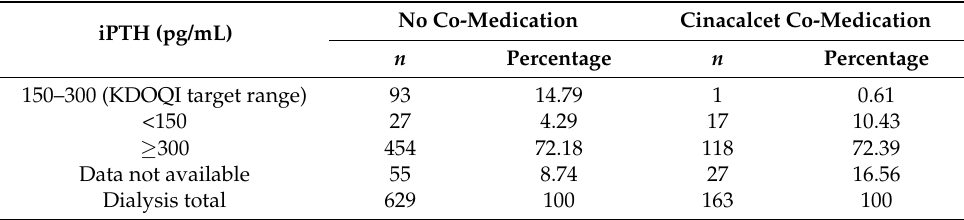
Table 5. Dialysis population at study start: iPTH KDOQI target attainment. iPTH